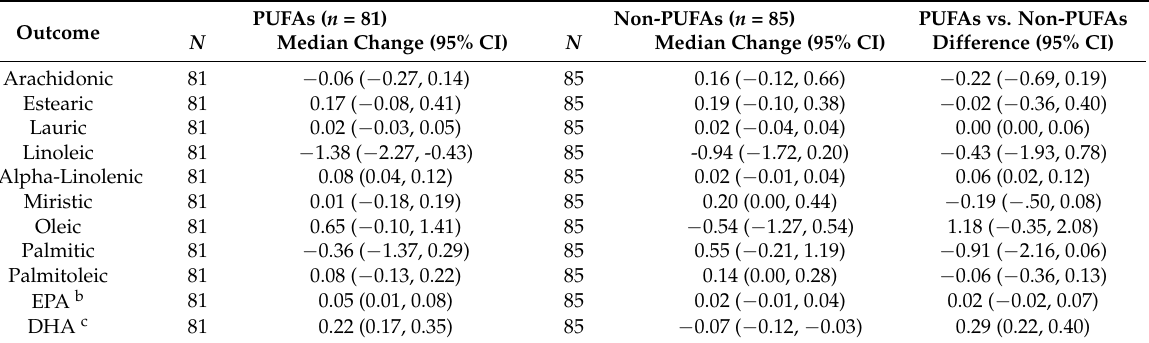
Table 3. Covariate-adjusted a median change for FA% between baseline and after four months, by treatment group. Outcome